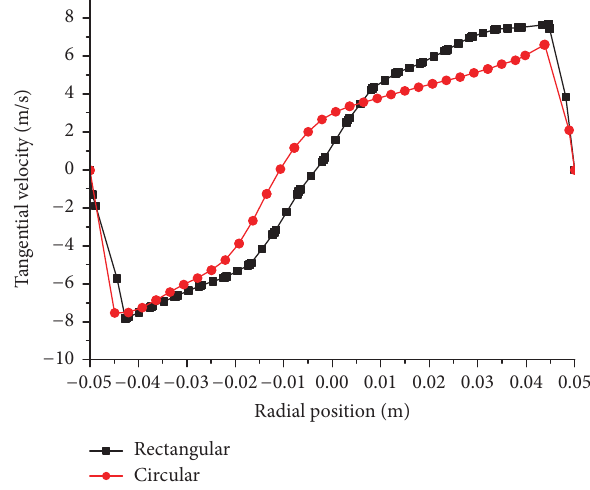
Figure 13: Tangential velocity distribution on the cross section of the separator middle position for two-inlet